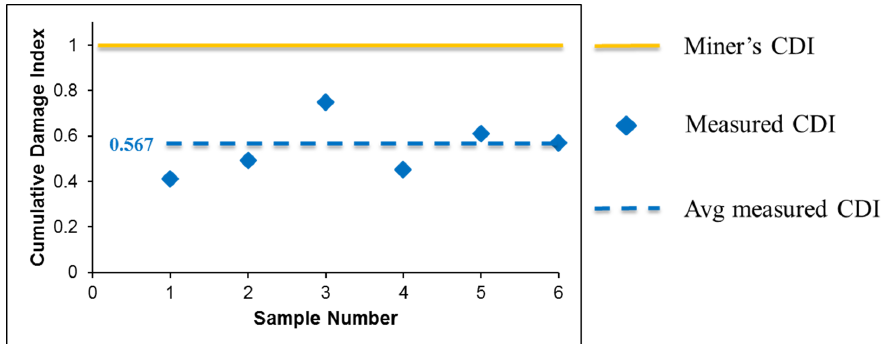
Figure 4. Breakdown of Miner’s